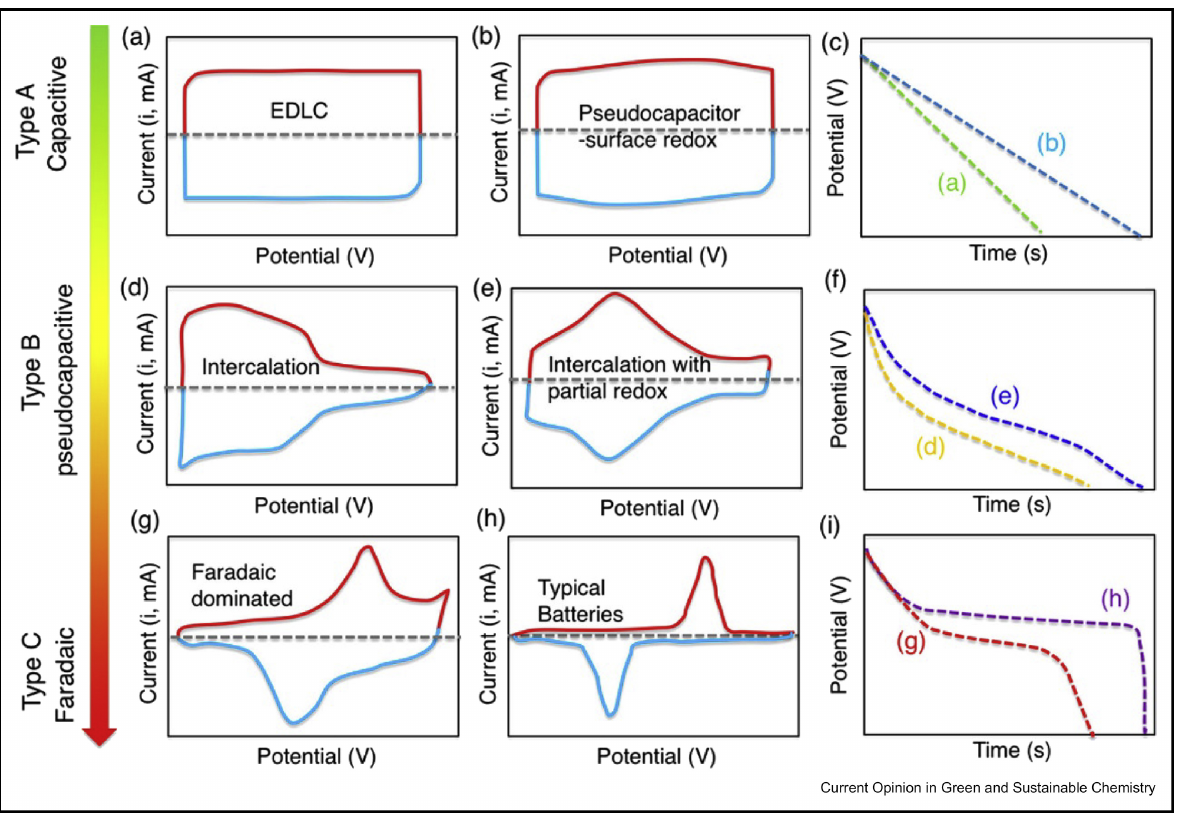
Figure 6. Schematic CV traces for different energy storage materials and their respective galvanostatic discharge curves. Each galvanostatic discharge curve is labelled with the letter of the corresponding CV trace. ( a – c ) Type A materials are distinctly capacitive, which includes EDLCs; ( d – f ) Type B are pseudocapacitive materials which are diffusion and/or intercalation limited; ( g – i ) Type C materials show a Faradaic battery-like response. Reprinted with permission from Ref. [4]. 2019,